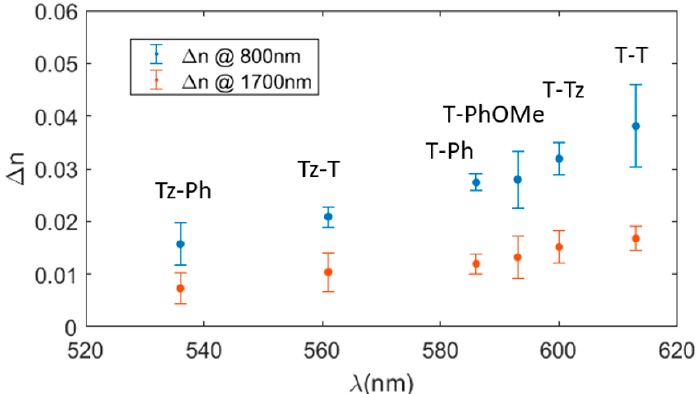
Figure 7. Δ n measured with ellipsometry at two different wavelengths for the polyurethanes under study. The results are plotted versus the peak position of the absorption band in the visible of the ring-closed form.